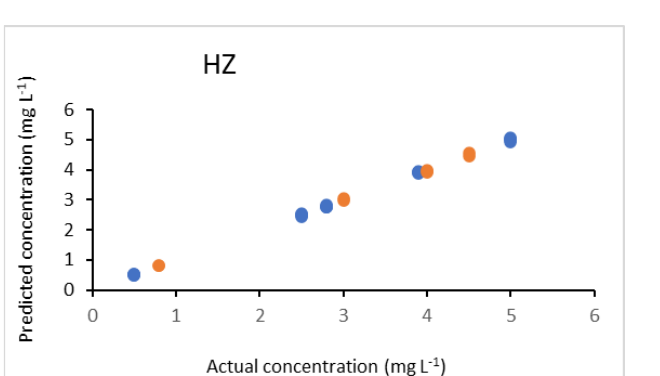
Figure 2. Plot of actual concentrations versus predicted values using MCR-ALS for calibration set ( ) and validation set ( ) of the investigated drugs. The high correlation coefficient (r 2 ) values of ≥ 0.9990 and the low relative error (RE) of ≤ 1.49% were obtained for the investigated drugs, which proved that the predictive ability of the developed MCR-ALS model is high. The performance parameters of the proposed MCR-ALS model are illustrated in Table 2. Table 2. Figures of merit of the developed MCR-ALS and PLSR models for the calibration and validation sets of the studied drugs.